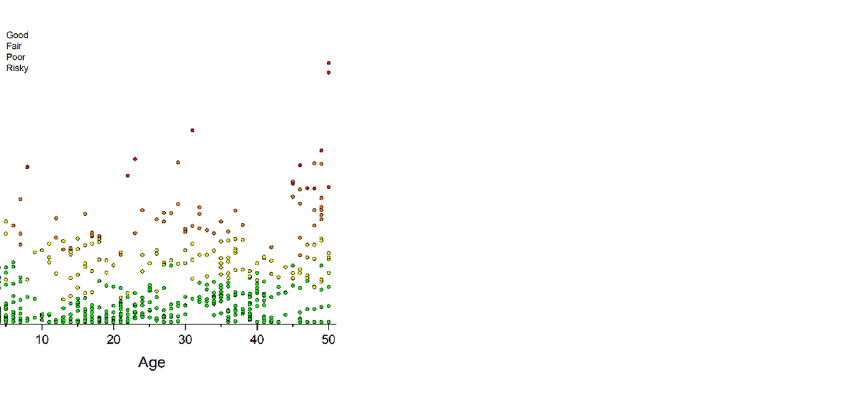
Figure 5. The results of the analysis of the power transformer technical condition for the whole study group using the presented health index method.